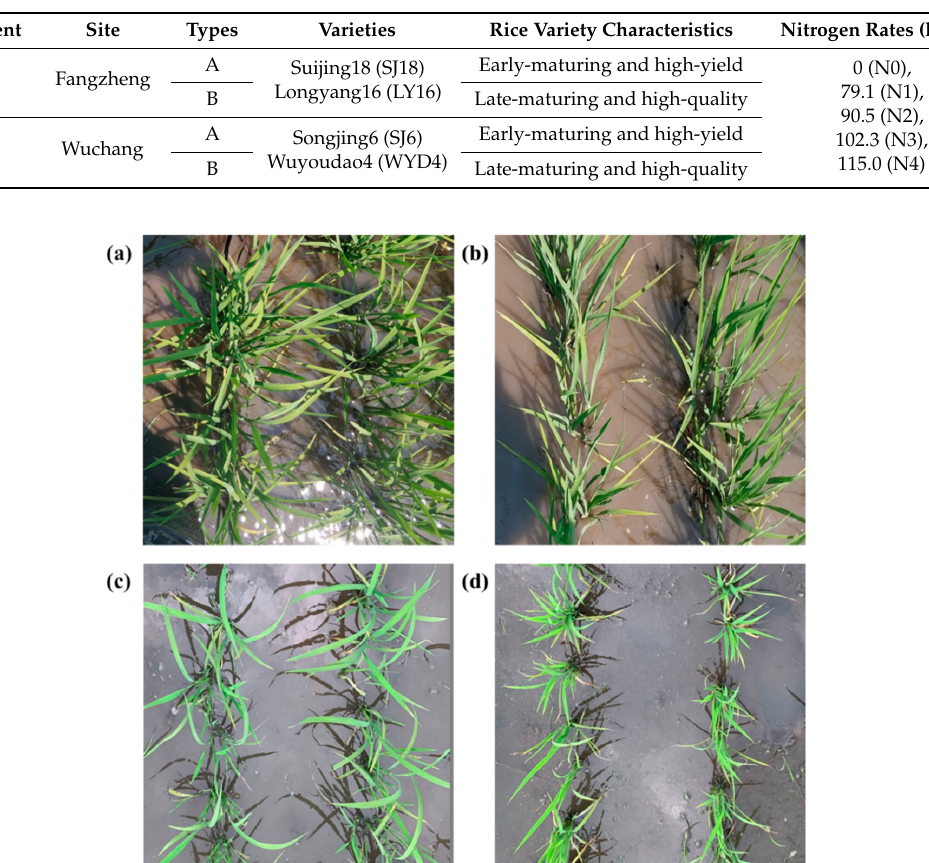
Table 1. Summary of the experimental design used in this study.